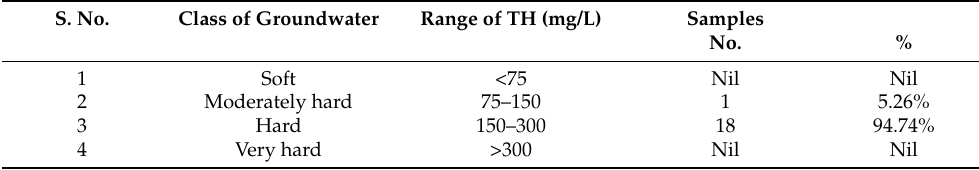
Table 4. Groundwater classification on the basis of total hardness (TH). S. No. Class of Groundwater Range of TH (mg/L) Samples